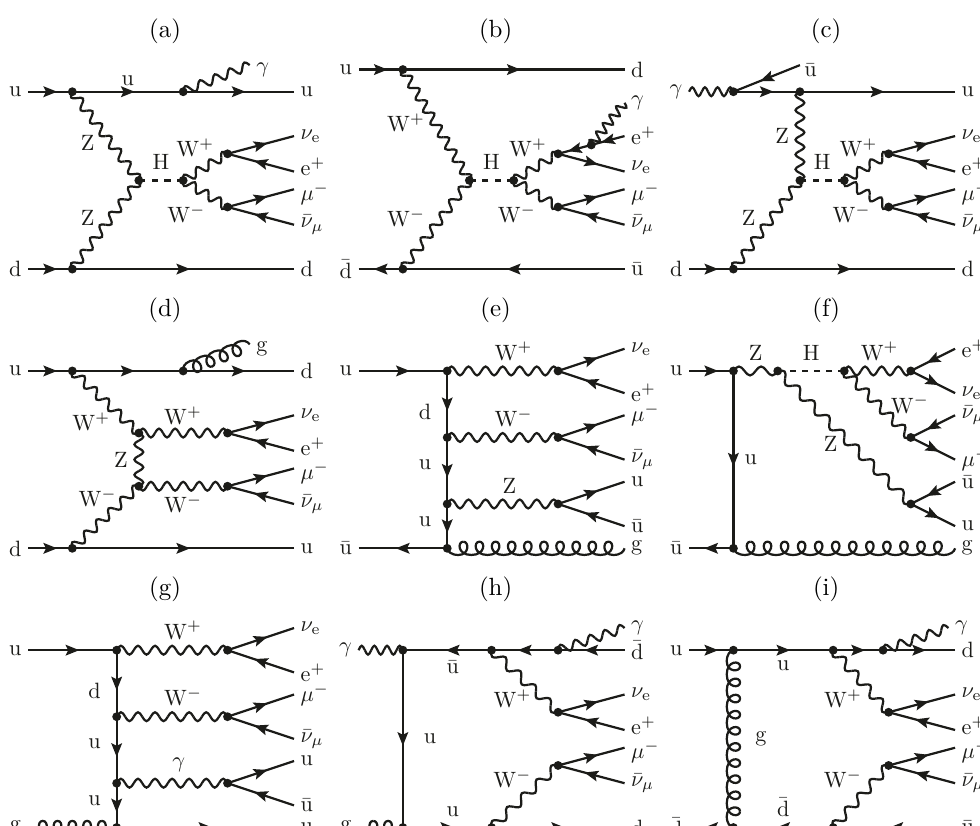
(cid:0) (cid:1) (cid:0) (cid:1) (cid:0) (cid:1) Figure 4. Examples of real-emission diagrams of g 7 , g s g 6 , and g 2 g 5 : in the first row s O O O emission of a real photon from a quark (a) or a lepton line (b) and initial-state photon splitting (c). In the second row gluon emission from signal (d) and background (e,f) diagrams. In the third row a gluon-induced process with final-state photon splitting (g), photon emission from a photon-gluon-induced diagram (h) and from a QCD-induced diagram (i). Note that diagrams of (cid:0) (cid:1) g 2 g 5 only contribute via interferences within of the calculations of this article. s O (cid:0) α 2 (cid:0) α 3 At the orders α 5 (cid:1) and α 4 (cid:1) , which we do not discuss in this article, VBS s s O O never appears as a